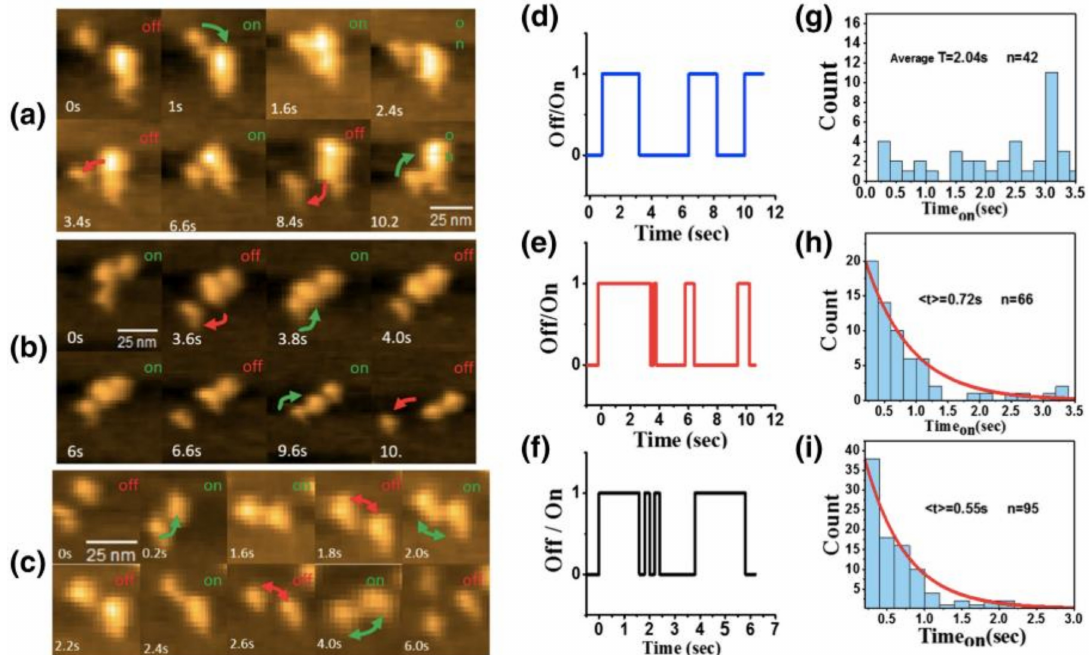
Figure 9. HS-AFM imaging and kinetic analyses of interaction between A β oligomers. Successive HS-AFM images ( a – c ), representative time courses of binding / dissociation ( d – f ), and distributions of the bound state ( g – i ) for the interaction of A β 15–20 nm –A β Agg ( a , d , g ), A β 15–20 nm –A β 36 nm ( b , e , h ), and A β 15–20 nm –A β 15–20 nm . Reprint with permission [113]: Copyright (2019),